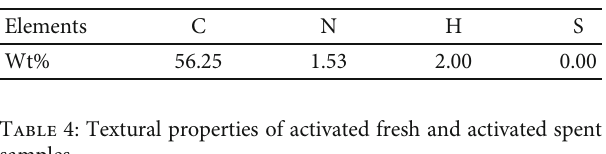
Table 3: CHNS analysis of SpLAC.